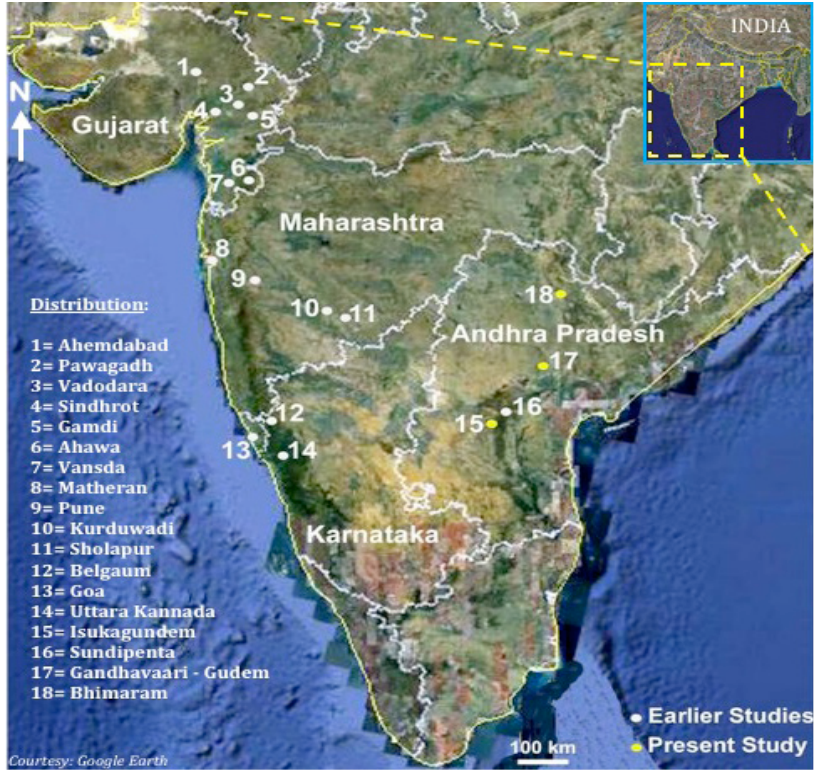
Image 1. Satellite image depicting distribution sites of L. guentheri in India Table 1. Morphometry of L. guentheri based on a specimen from Bhimaram, Adilabad District, Andhra Pradesh Particulars